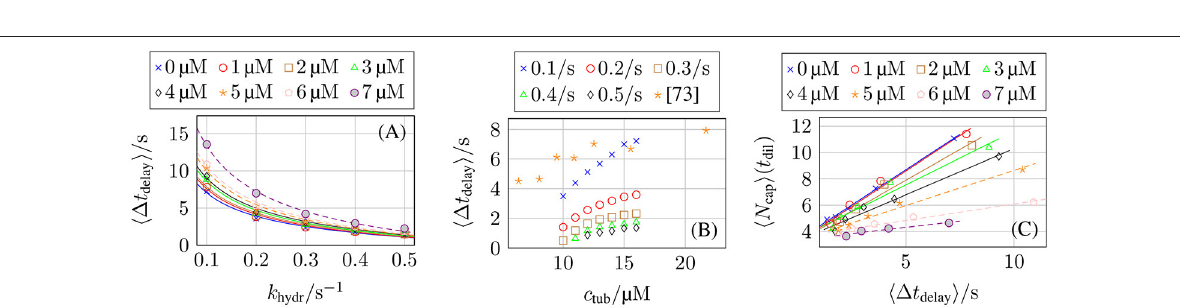
FIGURE 13 | (A) Length of a MT ℓ MT as a function of the simulation time t sim with k + = 4 µ M − 1 s − 1 , 1 G 0 ∗ long = − 9.3 k B T , k lat = 100 k B T / nm 2 , c tub = 9 µ M and k 0 hydr = 1.5s − 1 with hydrolysis being coupled to mechanics and (B) the two-dimensional representations of certain MT tip configurations that are marked by arrows in the inset (A.C) (configuration 6* has been shifted toward the MT tip by 21 tubulin dimer lengths).